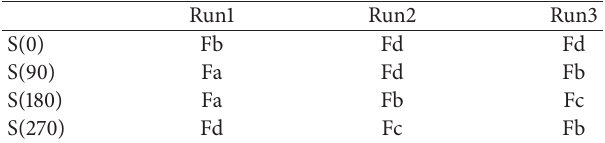
Table 1: Membrane binding orientations of hIAPP monomer at POPC bilayer. Our MD runs start from four different initial states S(0), S(90), S(180), and S(270). For each initial state, there are three independent 120 ns MD runs, and the final binding orientations are identified using the data of last 20ns. According to the residues binding to the bilayer surface, four different binding orientations are identified and they are named as Fa, Fb, Fc, and Fd. These four binding orientations are given in Figure